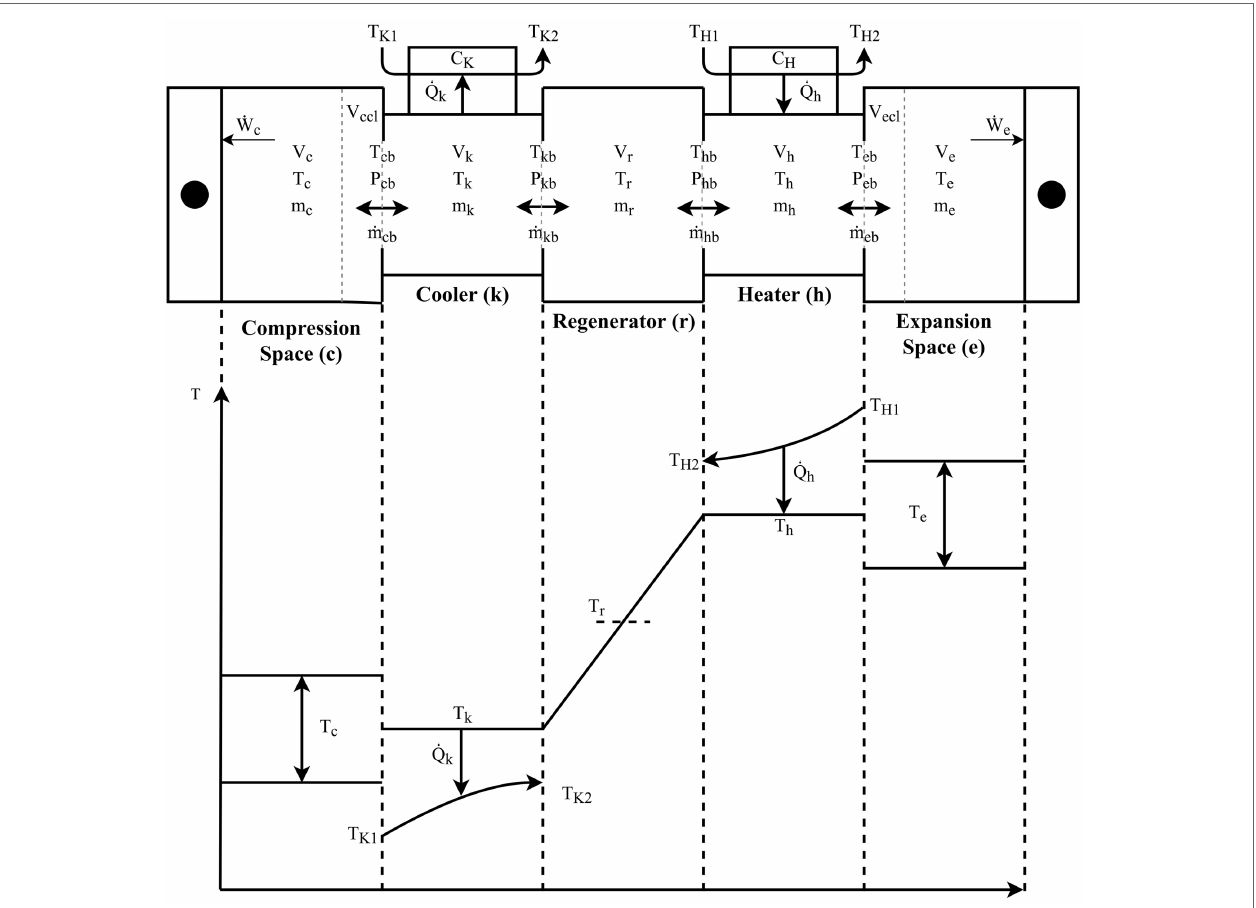
FIGURE 2 | Serially connected component and temperature diagram of the Stirling cycle.